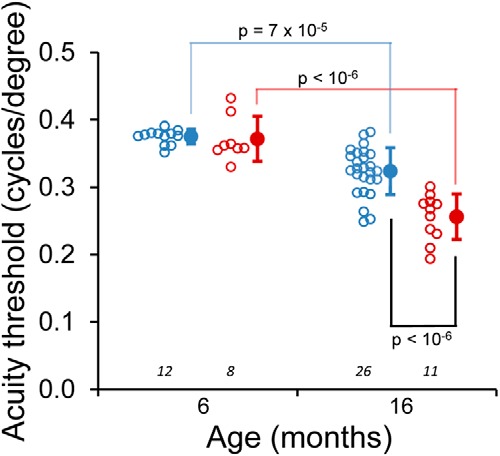
Decreased visual acuity in Fbn1Tsk
/+ mice at advanced age. Age-dependent decline in visual acuity was observed for wt (blue symbols) and Fbn1Tsk
/+ mice (red symbols). At six months of age, there was no significant difference between wt and Fbn1Tsk
/+ mice. At 16 months of age, Fbn1Tsk
/+ mice showed decreased acuity with respect to wt. Open symbols: individual mice; closed symbols: mean ± SD. Numbers of mice indicated in italics below each group.